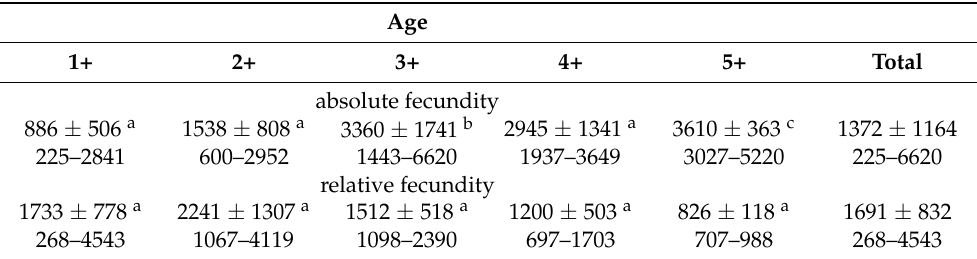
Table 4. Absolute and relative fecundity of the stone moroko, Pseudorasbora parva . Data are presented as mean ± SD and